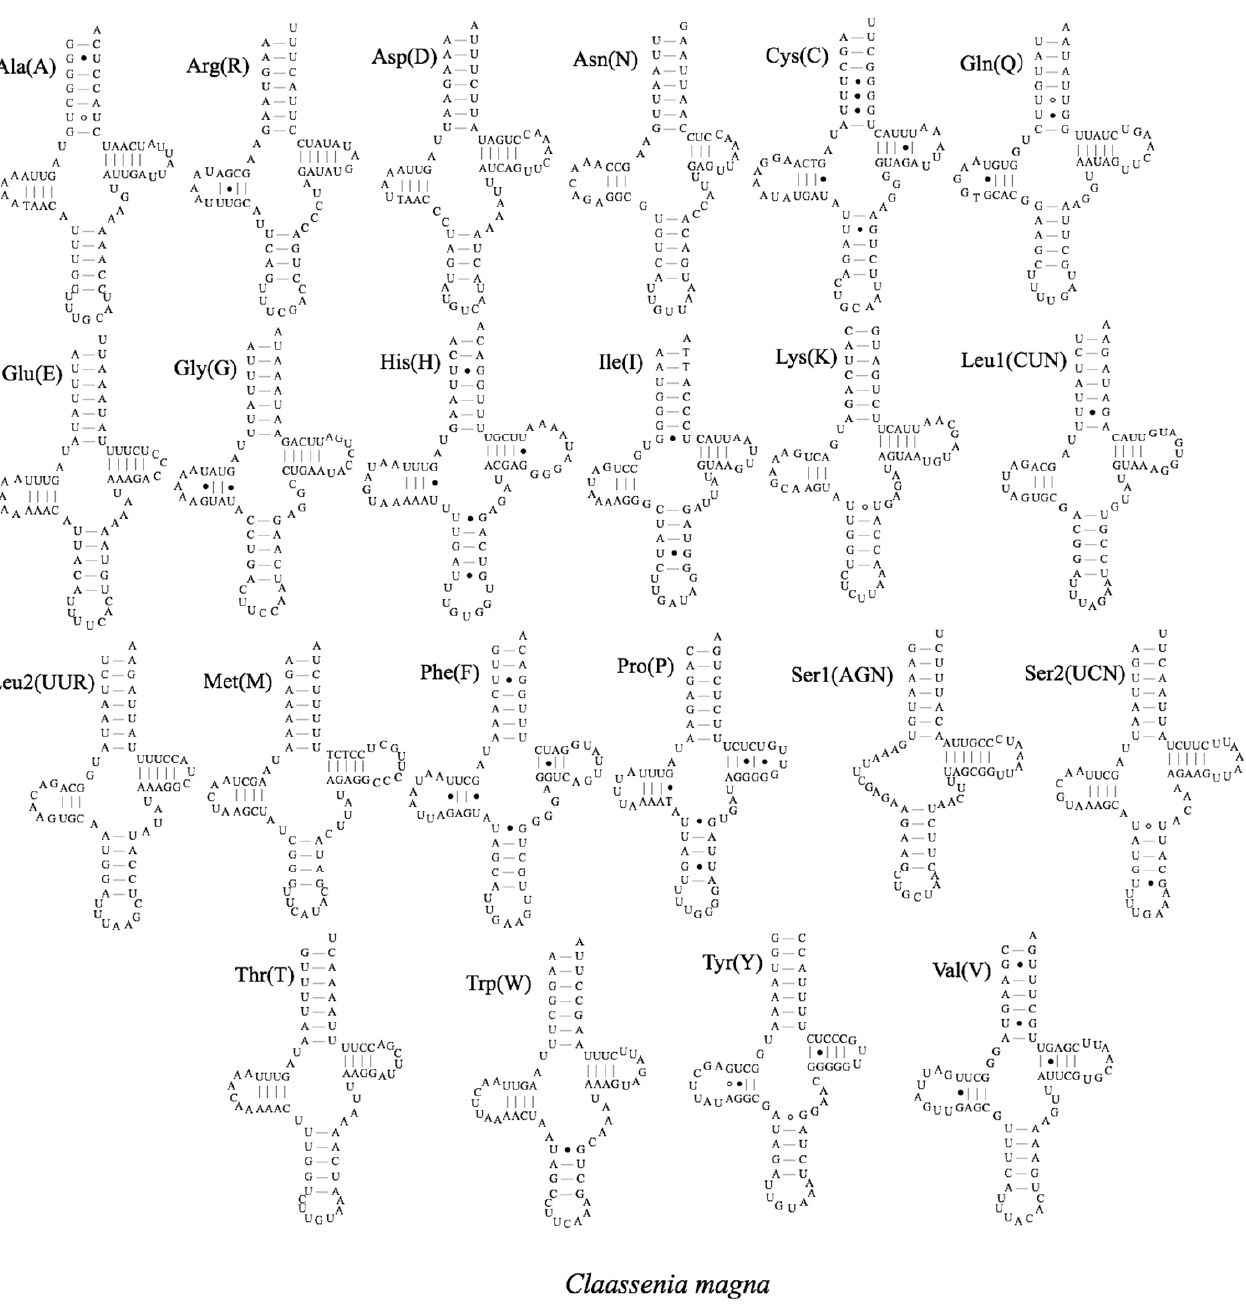
Figure 3. Predicted secondary structures of tRNAs in C. magna . The tRNAs are labelled with abbreviations of their corresponding amino acids.